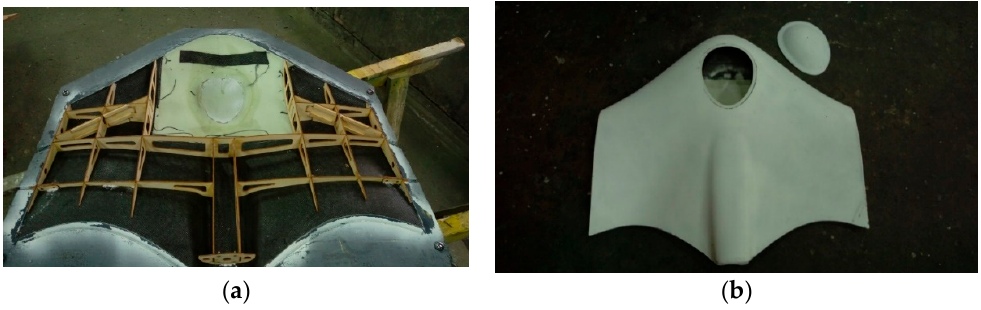
Figure 12. ( a ) Upper mold of the fuselage with ribs and ( b ) main structural modules (fuselage).